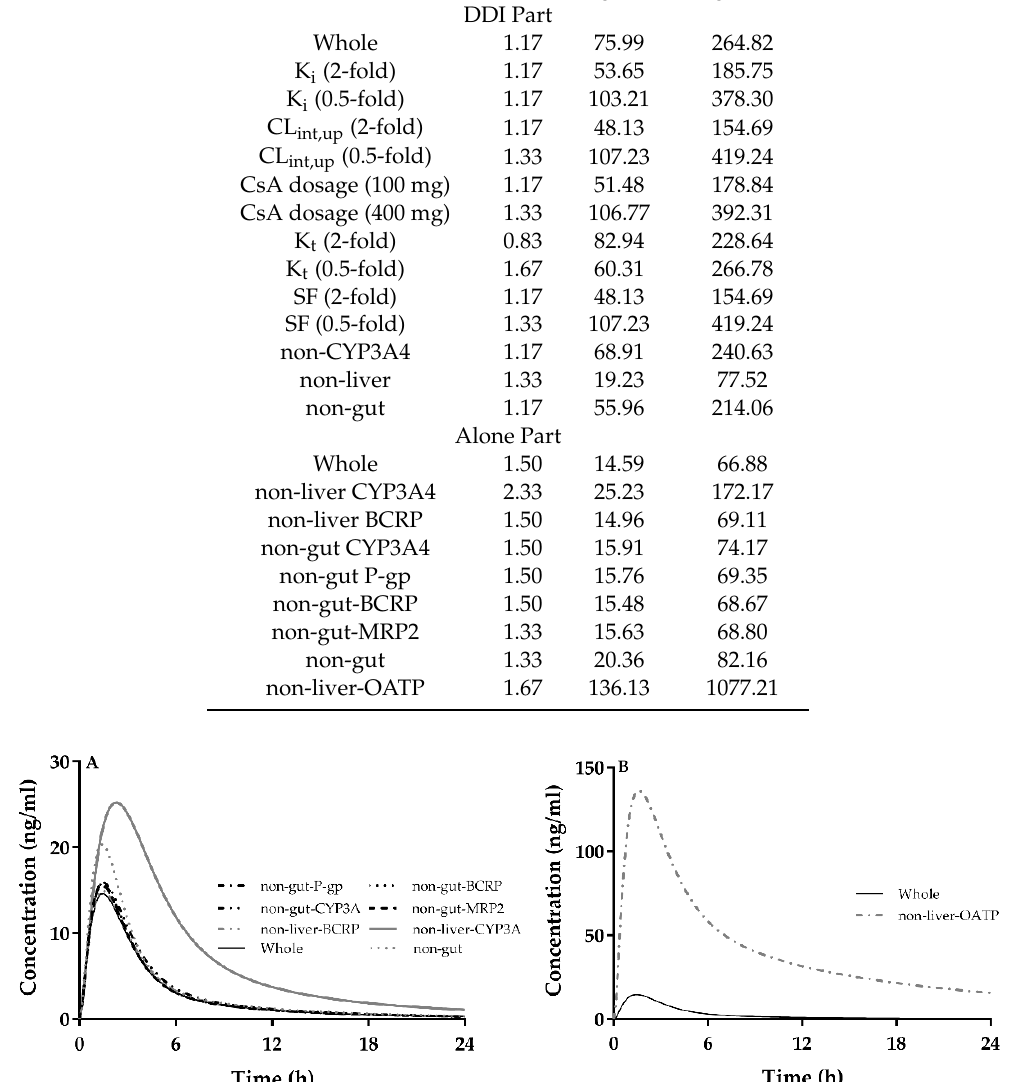
Figure 4. Effects of ( A ) hepatic CYP3A4 (non-liver CYP3A4), hepatic BCRP (non-liver BCRP), intestinal CYP3A4 (non-gut CYP3A4), intestinal P-gp (non-gut P-gp), intestinal BCRP (non-gut-BCRP), intestinal MRP2 (non-gut-MRP2) and integrated effects of the intestine (intestinal CYP3A4, intestinal P-gp, intestinal MRP2 and intestinal BCRP, non-gut) to plasma concentrations of atorvastatin following oral 40 mg of atorvastatin, which was compared with actual concentrations (Whole), ( B ) hepatic OATPs (non-liver-OATP).